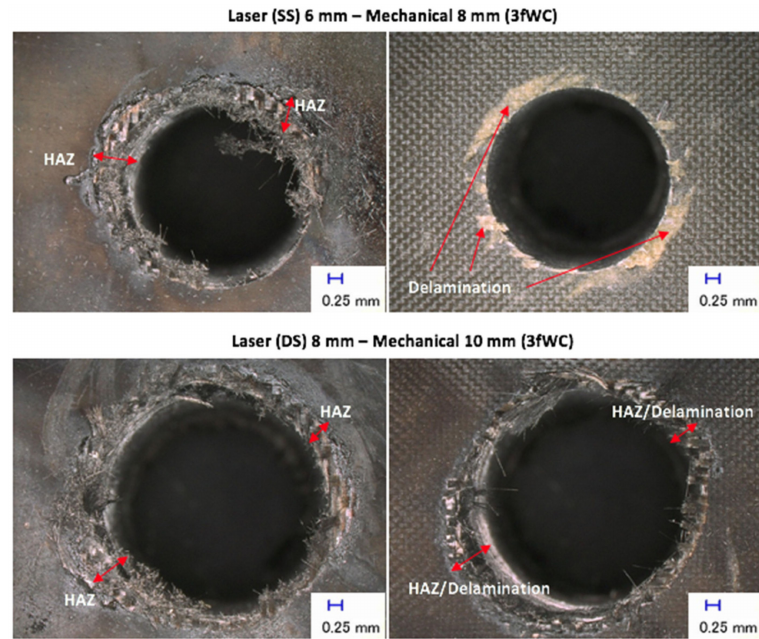
Figure 5. Typical examples of sequential laser–mechanical drilling